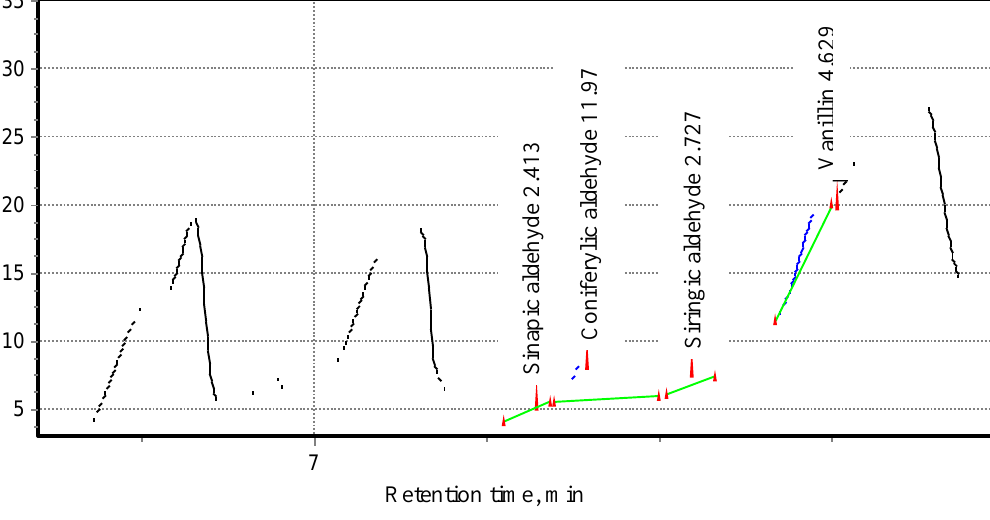
Fig. 3. Electrophoregram of aqueous-alcoholic extract of common St. John's wort herb (4-time dilution). Table 2. Content of total of tannins in the extracts of shell of pine nuts, wild camomile flowers and